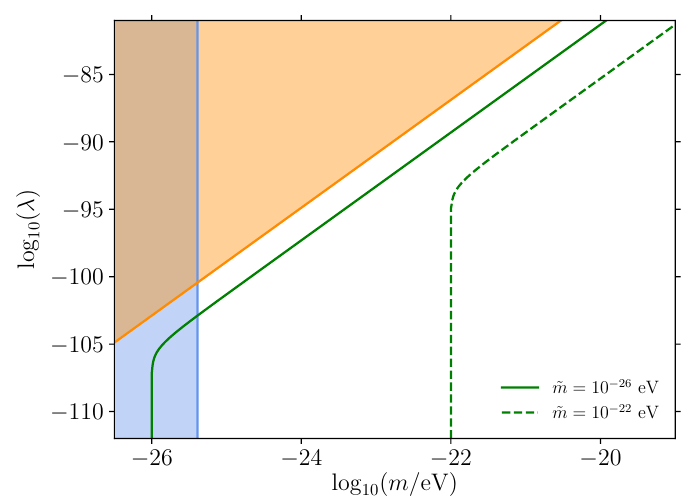
Figure 1 . Di(cid:11)erent heuristic bounds. Orange region corresponds to the parameter-space excluded for the e(cid:11)ects of (cid:21) on the background evolution. In the blue region, the e(cid:11)ect of a non-negligible sound speed results in a strong disagreement with observations, hence it is excluded. The green curves represent (4.12) for two di(cid:11)erent masses. According to the argument in the main text, points along each curve should give similar structure-formation